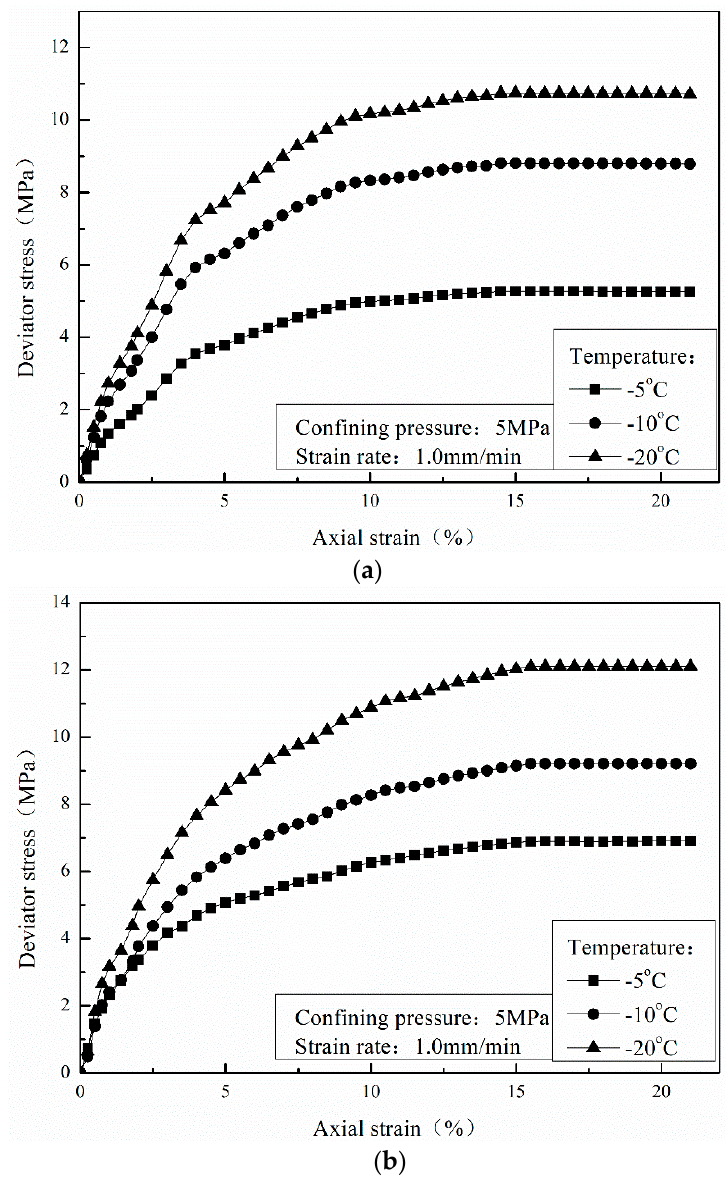
Figure 10. Stress-strain curves of the CH 4 and CO 2 hydrate-bearing sediments under different temperatures. ( a ) CH 4 hydrate-bearing sediments; ( b ) CO 2 hydrate-bearing sediments.